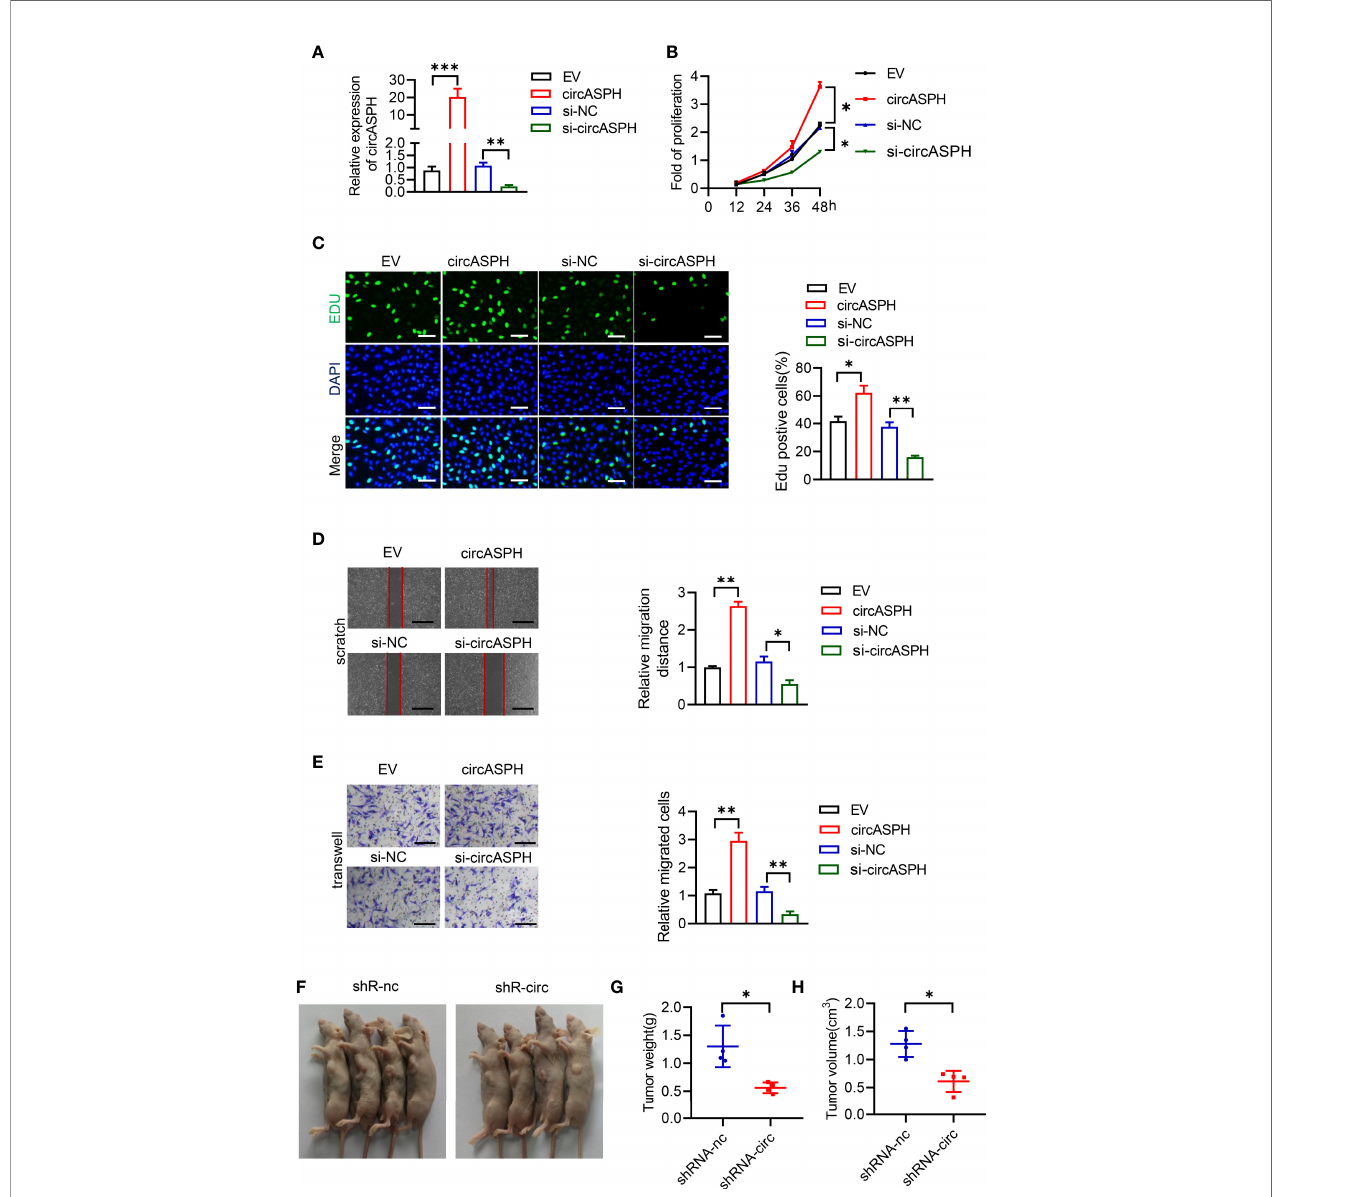
FIGURE 2 | CircASPH promoted HCC cell proliferation, migration, and invasion. (A) The expression of the circASPH level was detected by circASPH overexpressed and knocked down in HCC cells. (B, C) Cell Counting Kit-8 (CCK-8) assays and EDU staining assays were used to indicate the function of circASPH in the proliferation of HCC cells. (D) Wound-healing assays showed the role of circASPH in the migration of HCC cells. (E) Transwell assays showed the function of circASPH in the invasion of HCC cells. (F – H) Xenograft tumors composed of shRNA-circASPH-transfected HCC cells were signi fi cantly smaller than those composed of shRNA-NC-transfected HCC cells. *p < 0.05, **p < 0.01, ***p <